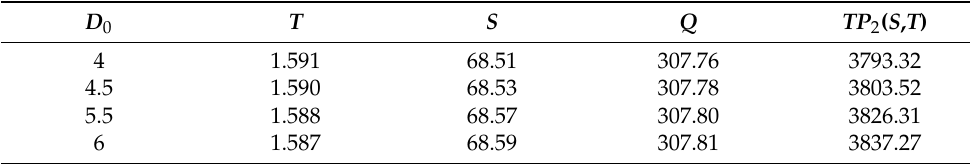
Table 11. Impact of upstream trade credit ( M ) .